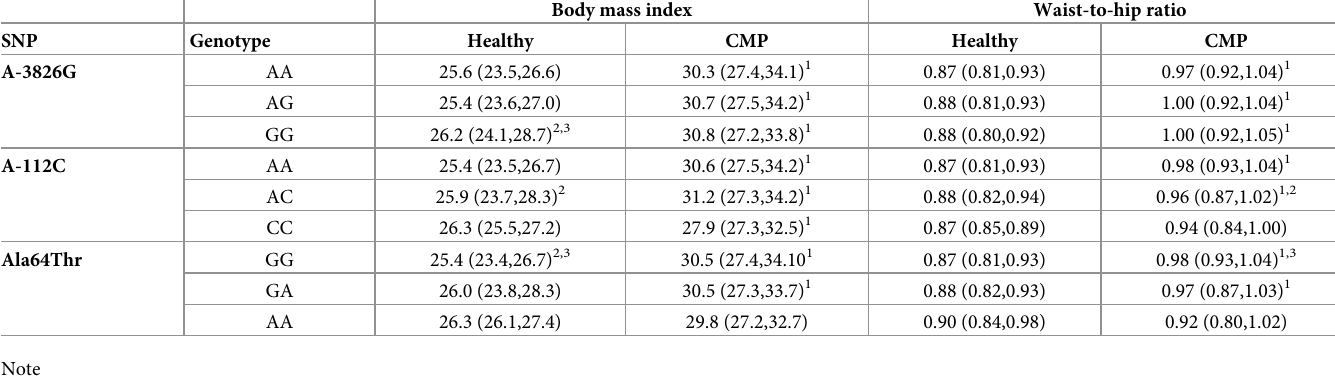
Table 3. Body mass index and waist-to-hip ratio [median (Q1, Q3)] across the different UCP1 SNPs for the entire sample as well as across healthy controls and indi- viduals with